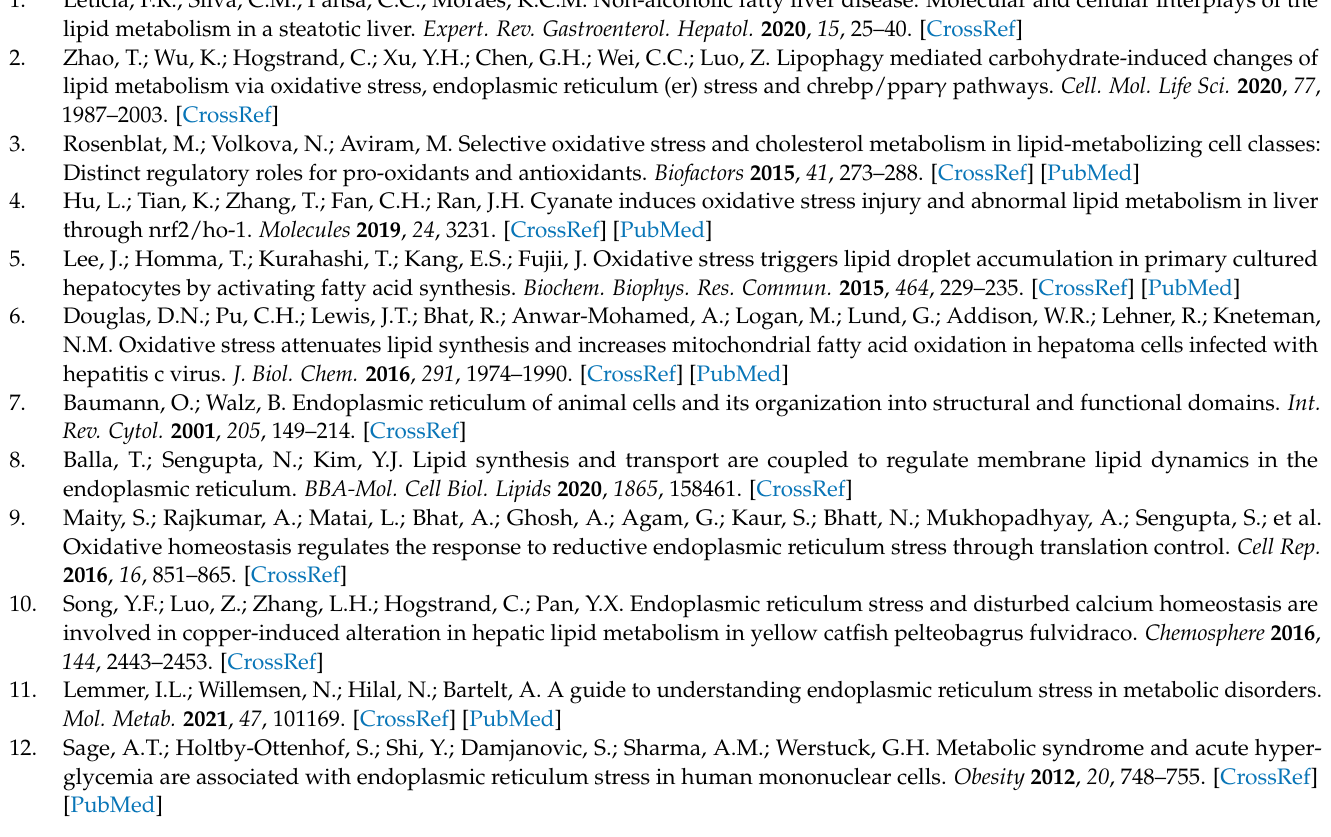
Figure S2: The expression of selenotranscriptome in the liver; Table S1: Composition and nutrient levels of the basal diet; Table S2: The oxidation Characteristics of the diets; Table S3: Primers used for the Q-PCR; Table S4: The correlation analysis between the major selenoprotein-encoding genes and lipid metabolism